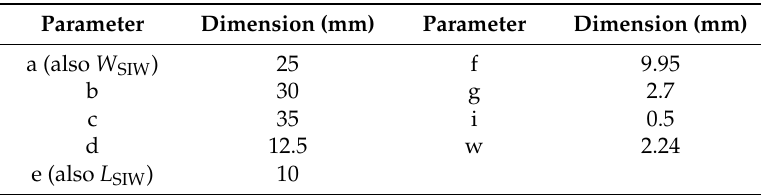
Figure 4. Proposed SIW chemical sensor (top view). Table 1. Design parameters of the proposed SIW chemical sensor.